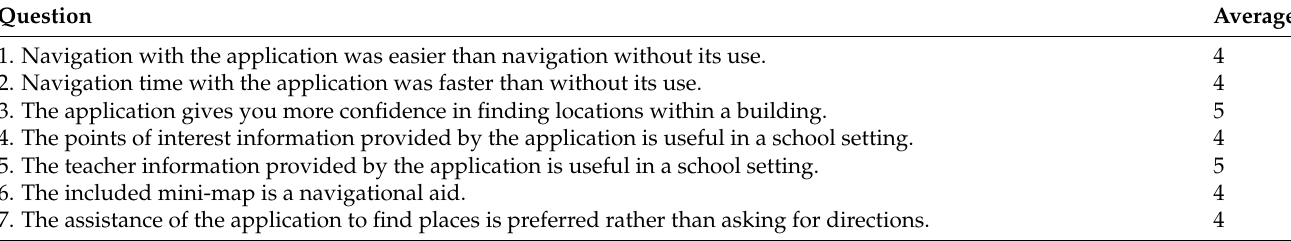
Table 3. Average result of the survey applied on a Likert scale. 1 = Strongly disagree, 2 = Disagree, 3 = No preference, 4 = Agree, 5 = Strongly